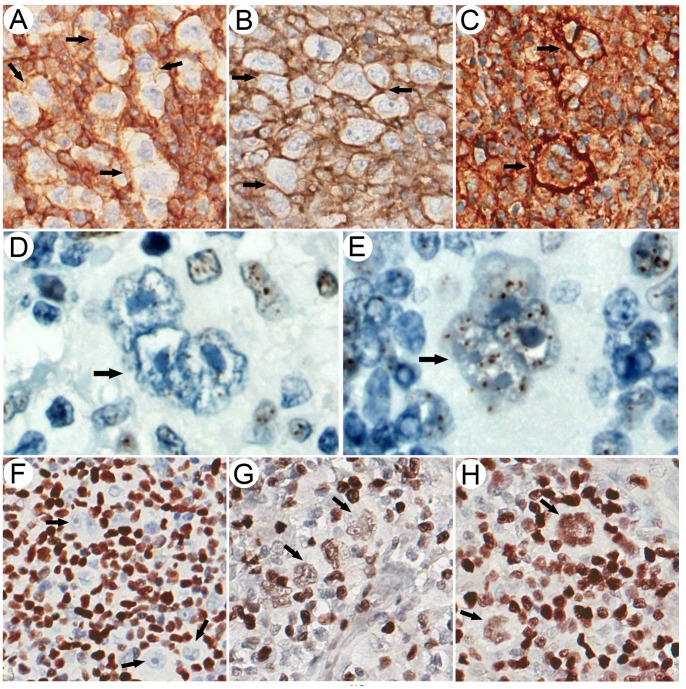
Representative immunostaining results of HLA class I, SATB1 and PML-NBs.Arrows indicate the HRS cells. (A) HLA class I negative case. There is no membranous staining between adjacent HRS cells, while membranes of surrounding cells were positive. (B) HLA class I positive case. Several adjacent HRS cells show positive membranous staining at the same intensity as the surrounding lymphocytes. (C) cHL case with a strongly positive HLA class I staining. Staining intensity of HRS cells is more pronounced than the intensity of the surrounding lymphocytes. (D) cHL case with an average of ≤10 PML-NBs per cell. One HRS cells with 4 tiny PML-NBs in the nucleus is shown. (E) cHL case with an average of >10 PML-NBs per cell. A representative HRS cell with more than 20 PML-NBs in the nucleus is shown. (F) cHL case without nuclear SATB1 staining in HRS cells. (G) Weakly positive nuclear SATB1 staining in HRS cells. (H) Positive nuclear SATB1 staining in HRS cells.